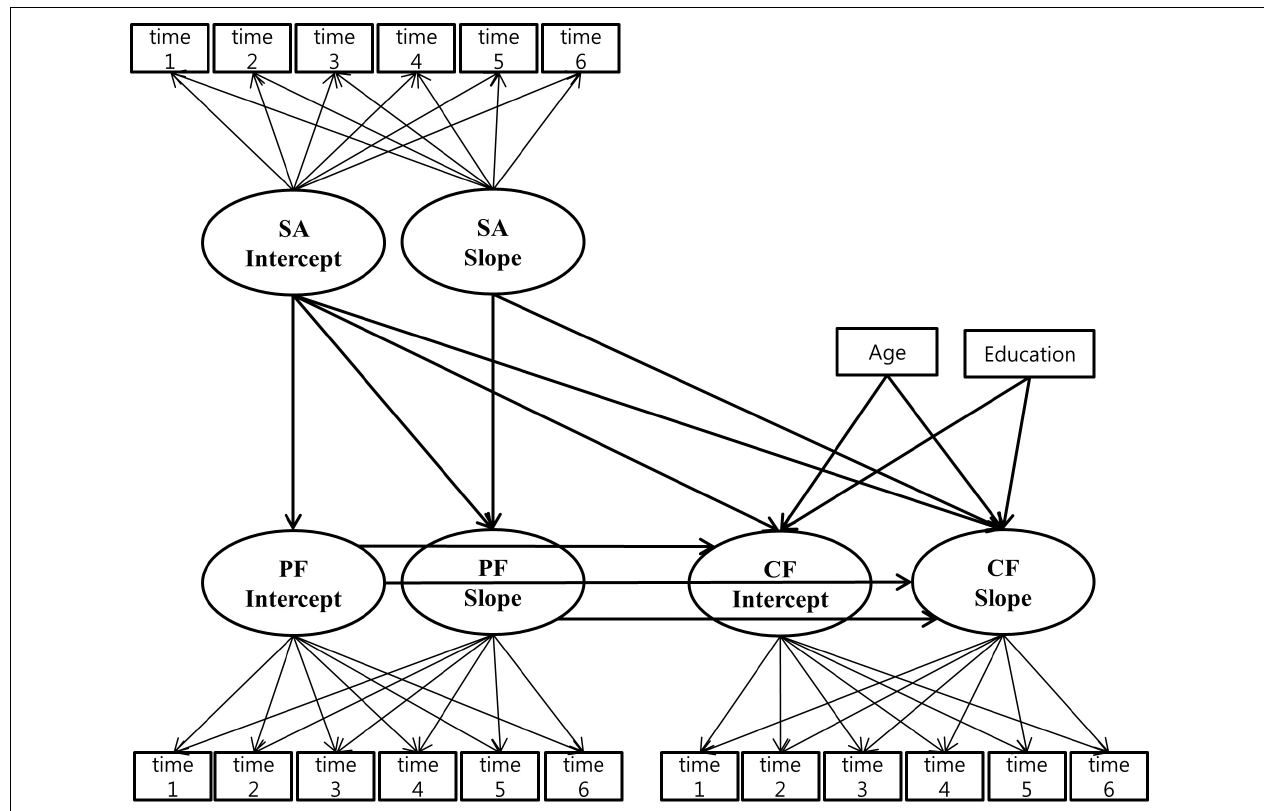
FIGURE 1 | Multivariate latent growth model. PF, physical dysfunction; SA, social activity; CF, cognitive